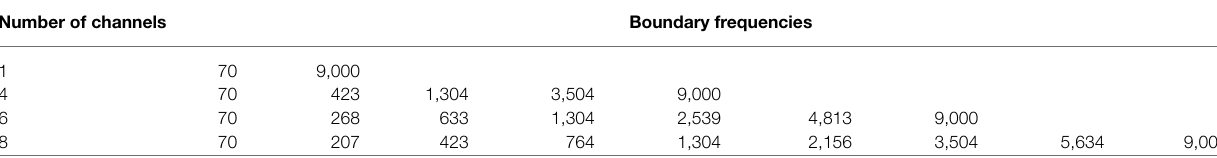
TABLE 1 | Boundary frequencies (in Hz) for 1, 4, 6, and 8 channels noise-vocoding conditions. Number of